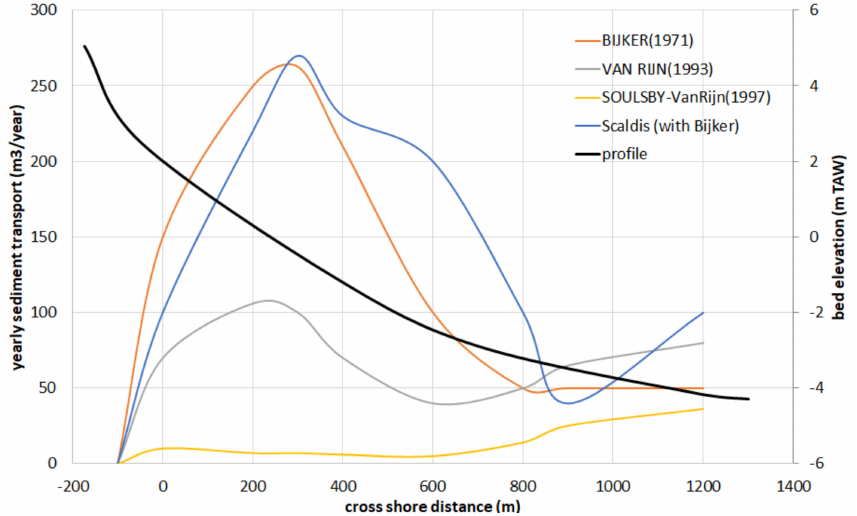
Figure 14. Comparison of the sediment transport rates using different formulations in Unibest with the results of Scaldis-Coast, for a relatively shallow